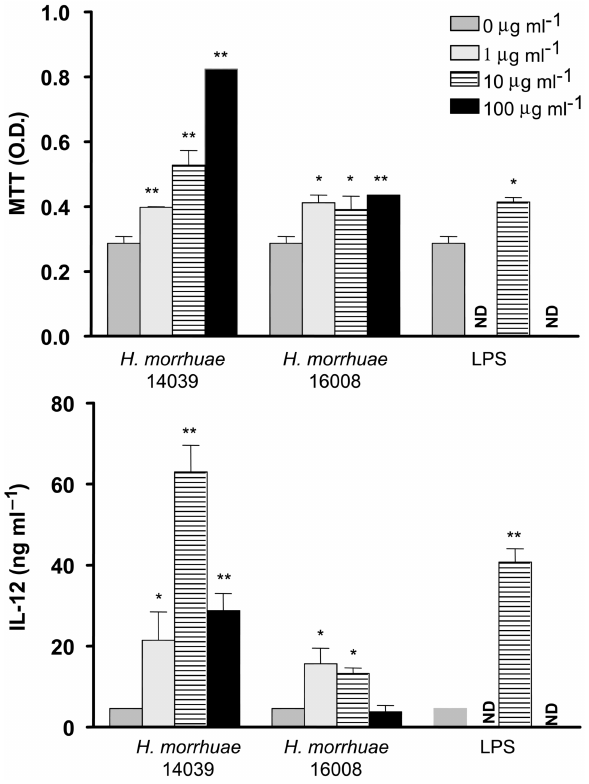
Figure 10. In vitro activation of murine bone marrow dendritic cells by archaeosomes of various lipid compositions. Bone marrow den- dritic cells were incubated for 72 h in the presence of antigen-free ar- chaeosomes prepared from total polar lipids of H. morrhuae strains 14039 and 16008. Means for MTT assays and IL-12 secretions are shown ± standard deviations for cultures in triplicate. Lipopoly- saccharide (LPS) at 10 µg ml –1 was used as a positive control. ND = not determined; * and ** = values statistically different by Student’s t -testat 95% and 99% confidence levels, respectively, comparedto the R8 medium control.